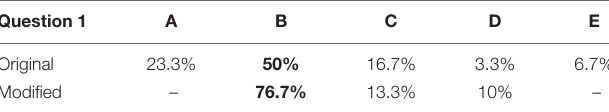
TABLE 1 | Percentages of choices of each urn recorded with the two versions of the task. Question